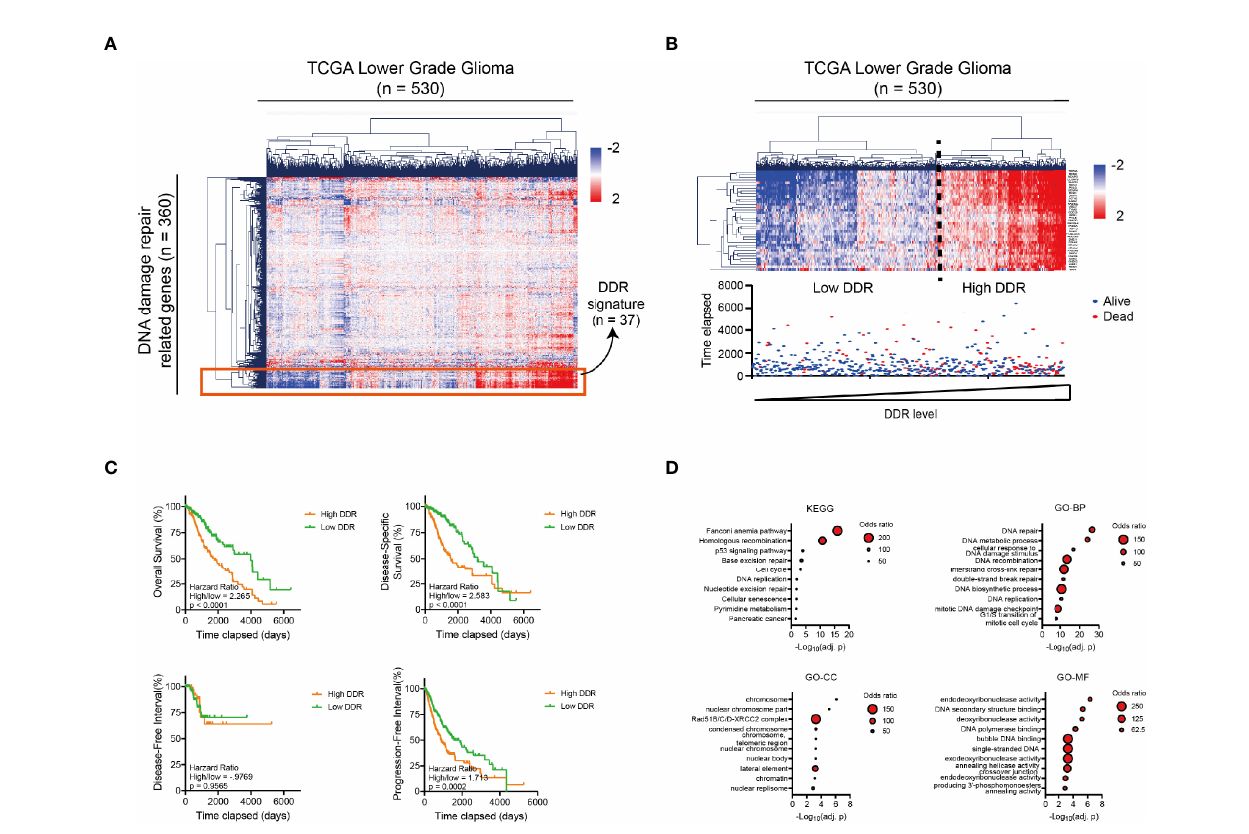
FIGURE 1 | The DNA damage repair landscape of low-grade glioma patients in TCGA database. (A) Heatmap and Hierarchical Clustering showing the heterogenous expression of 360 DNA damage repair-related genes in 530 glioma patients in the TCGA database. A sub-cluster of highly homogeneously expressed genes is marked in the red square. (B) Top: heatmap and Hierarchical Clustering of the glioma patients with 37 DNA damage repair signature genes (n = 530) from Figure 1A . Patients can be divided into high or low DDR level group according to the Hierarchical Clustering result. Bottom: vital status of the glioma patients with different DNA damage repair levels as presented in the top fi gure (n = 530). Deceased patients are labeled in red and censored/living patients are labeled in blue. (C) Kaplan-Meier analysis showing the OS, DSS, DFI and PFI of glioma patients with high vs. low DNA damage repair level according to the median (n high = 265, n low = 265). (D) Bubble diagram showing the KEGG and GO analysis results (including GO_BP, GO_MF and GO_CC) for 37 DNA damage repair signature genes. The size of each point represents the number of genes in the representative pathway. DDR, DNA Damage Repair; OS, Overall Survival; DSS, Disease-Speci fi c Survival; DFI, Disease-Free Interval; PFI, Progression-Free Interval; GO, Gene Ontology; BP, biological process; CC, cellular component; MF, molecular function; KEGG, Kyoto Encyclopedia of Genes and